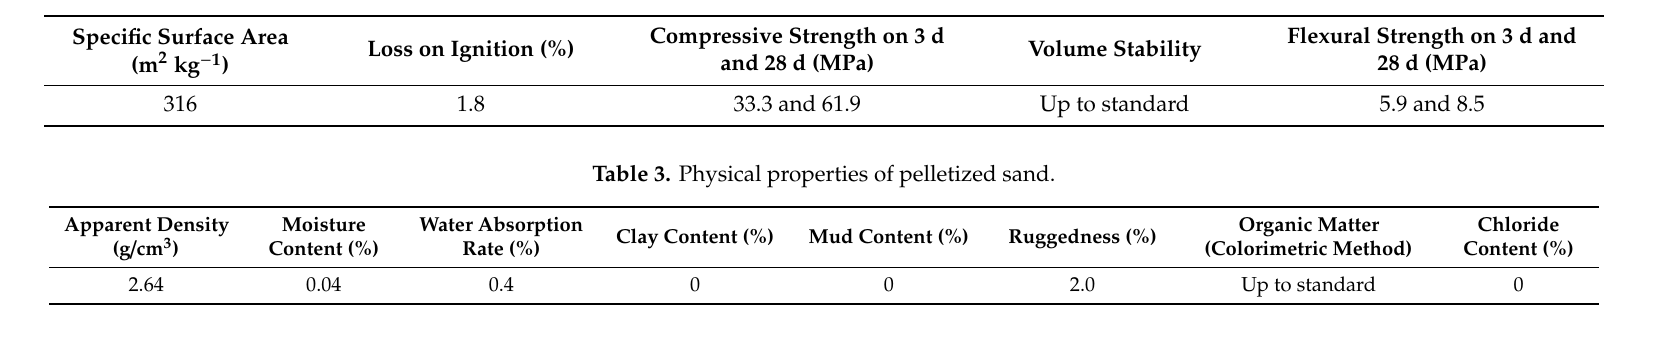
Table 2. Physical properties of cement.